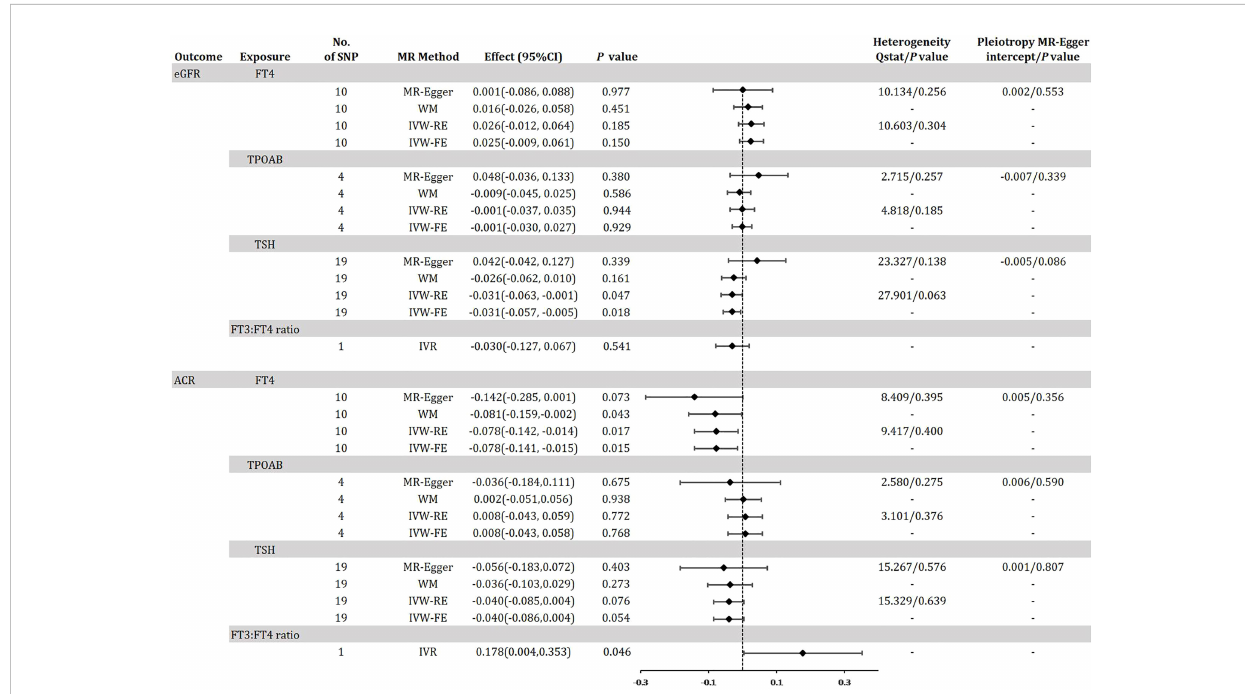
FIGURE 4 Odds ratio for association of genetically predicted thyroid function with eGFR and ACR in diabetes. FT4, free thyroxine; FT4, free thyroxine; FT3, free triiodothyronine; TSH, thyroid-stimulating hormone; TPOAB, thyroid peroxidase antibodies; eGFR, estimated glomerular fi ltration rate; ACR, urinary albumin-to-creatinine ratio; CI, con fi dence internal; OR, odds ratio; IVW-FE, inverse-variance weighted fi xed-effects MR; IVW-RE, inverse-variance weighted random-effects MR; MR, mendelian randomization; WM, weighted median; IVR, instrumental variable ratio (Wald) estimator; SNP, single- nucleotide polymorphism. P value for heterogeneity based on Cochran ’ s Q statistic for IVW, and Rücker ’ s Q for